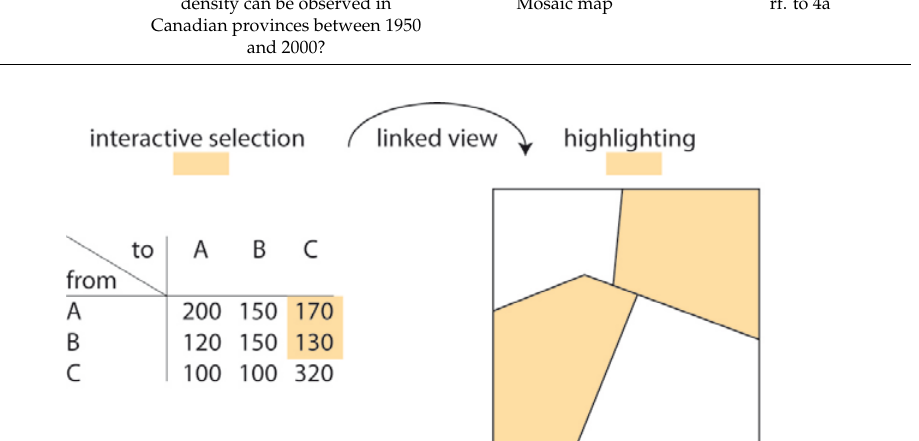
Figure 1. Linked view between change matrix and binary mosaic map for depicting various combinations of class changes (related task: “Is there any change from any class to class C in Canadian provinces between 1900 and 2000?”). In the case of metric data, absolute and relative values must be differentiated for visualization purposes, resulting in proportional symbol maps (4d) or choropleth maps (4e) [20]. If the value difference as such is not wanted, but only the trend (increase, decrease, none), one can refer to